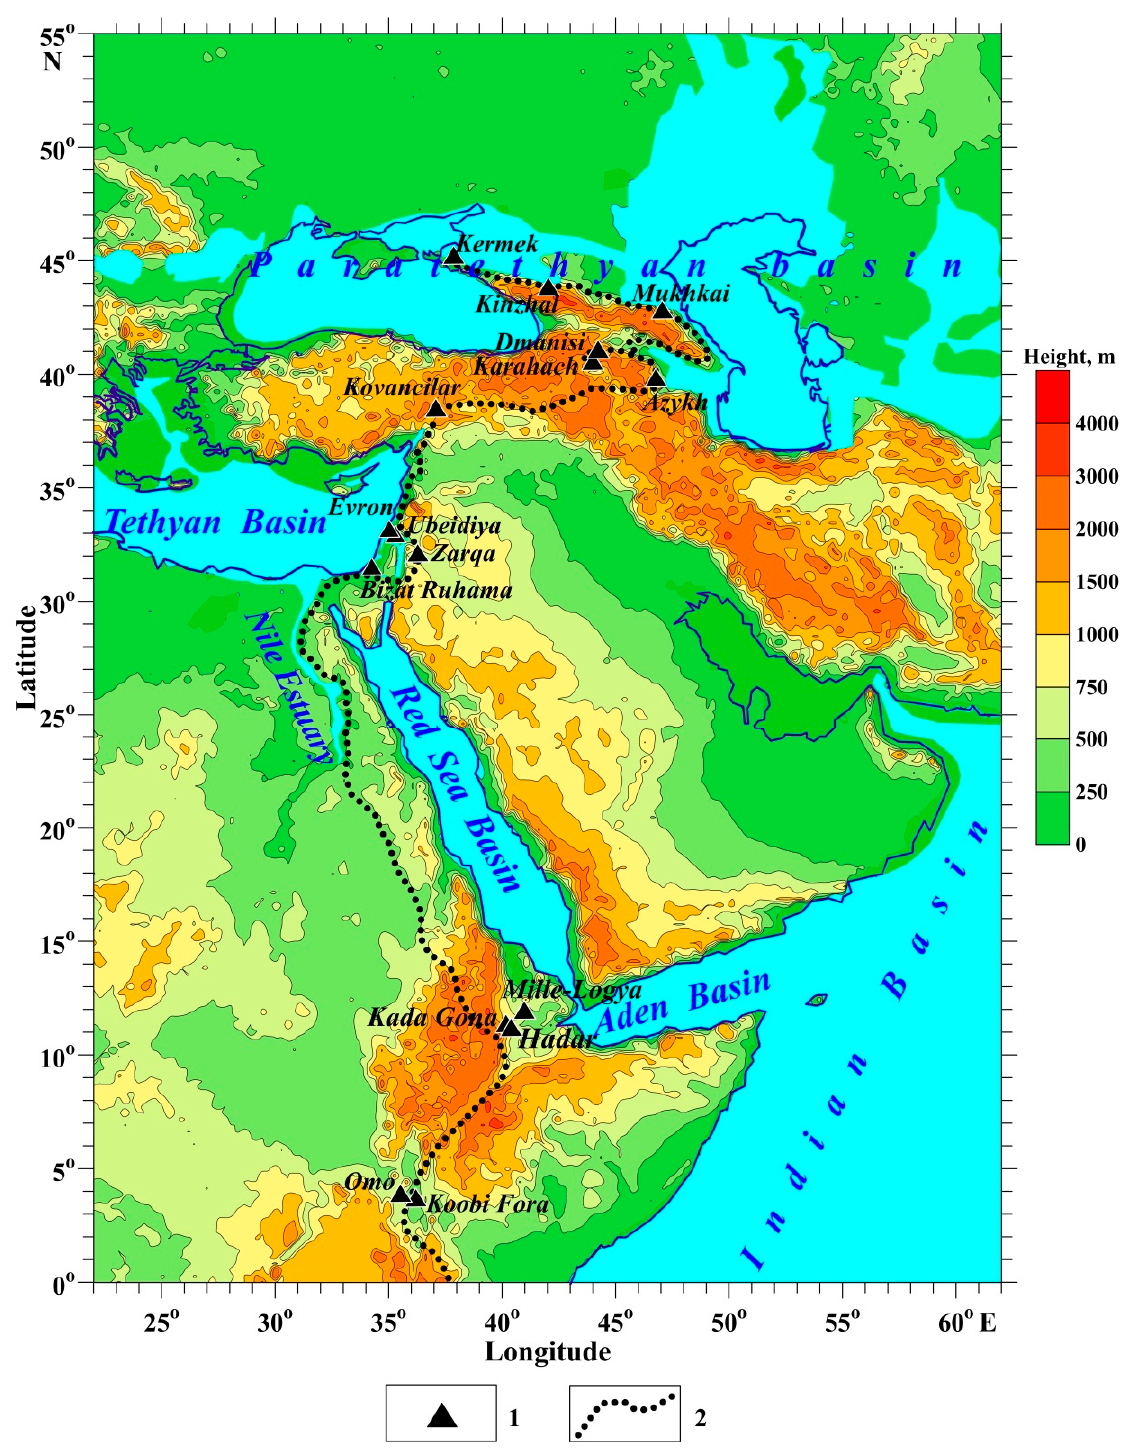
Figure 1. Geomorphological-paleogeographic map of the study area with the main tectonic elements and modern topography map. (1) ancient hominin sites of 2.6–1.2 Ma, (2) reconstructed ancient hominin way from Africa to Eurasia.